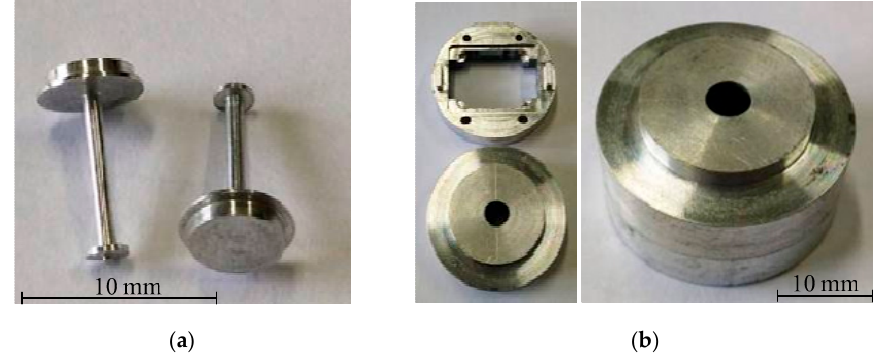
Figure 6. The photos of floating elements and package shells. ( a ) Floating elements; ( b ) Package shells.